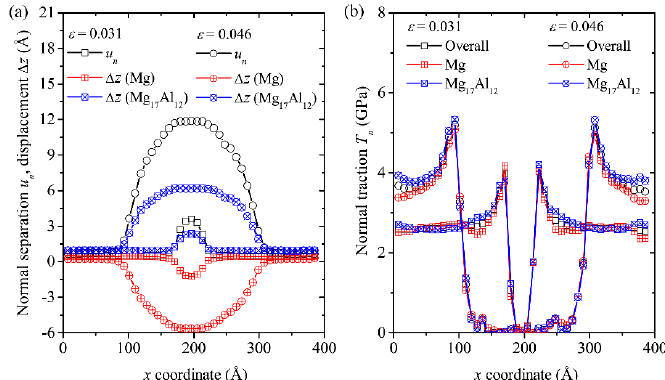
Figure 3. ( a ) Distribution of normal separation u n and displacement Δ z along the interface for two different strains. “ Δ z (Mg)” and “ Δ z (Mg 17 Al 12 )” are the average atomic displacement Δ z of all atoms in the “Mg” half and “Mg 17 Al 12 ” half of an CZVE, respectively. ( b ) Distribution of normal traction T n along the interface for two different strains. “Overall” indicates the average atomic stress σ zz of all atoms in each CZVE. “Mg” and “Mg 17 Al 12 ” are the average atomic stress σ zz of all atoms in the “Mg” half and “Mg 17 Al 12 ” half of an CZVE, respectively. The T n − u n curve was extracted from simulation, as shown in Figure 4. T n increases nearly linearly as u n increases, until reaching the maximum value which is known as cohesive strength σ c (corresponding u n is denoted by δ c ), followed by a descending trend to zero. The u n at which T n reduces to zero is δ s , indicating the complete separation of the interface. The T n − u n curve extracted from MD simulation was compared with that predicted by three widely used CZMs, namely cubic polynomial CZM [22], exponential CZM [23], and bilinear CZM [24]. In the cubic polynomial CZM,